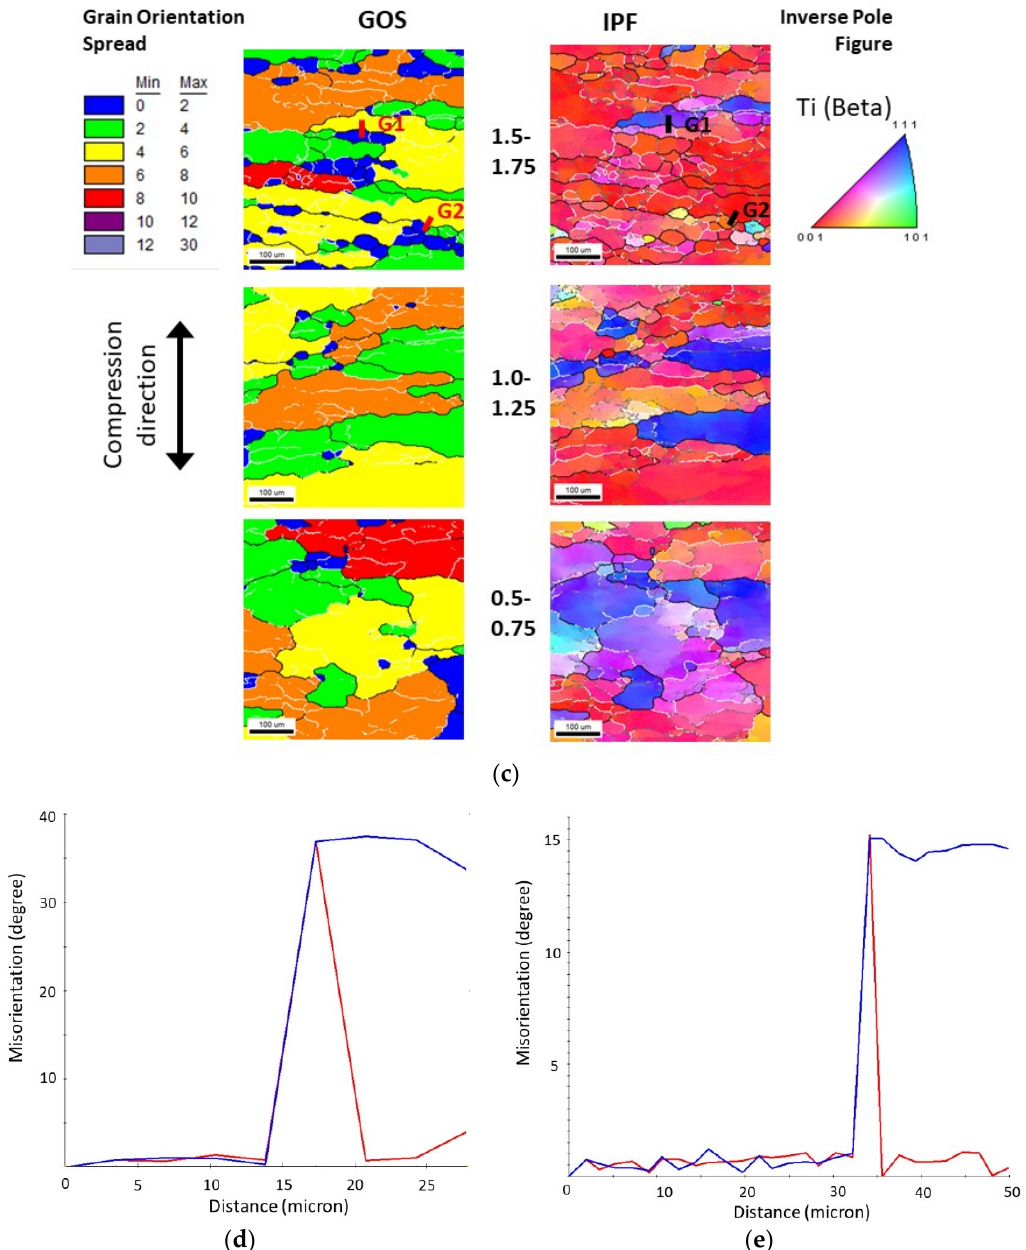
Figure 3. EBSD GOS and IPF maps of deformed microstructure of Ti55511 samples obtained for three different strain level regions that were deformed at 950 °C at nominal strain rates of ( a ) 1/s, ( b ) 0.1/s, and ( c ) 0.01/s. And misorientation measurement between grains of ( d ) G1 (having {001} recrystallized red grain vs {111} deformed blue grain) showing a higher misorientation than that of ( e ) G2 (having recrystallized red grain vs deformed red grain) at strain regions of 1.5–1.75 shown in ( c ).